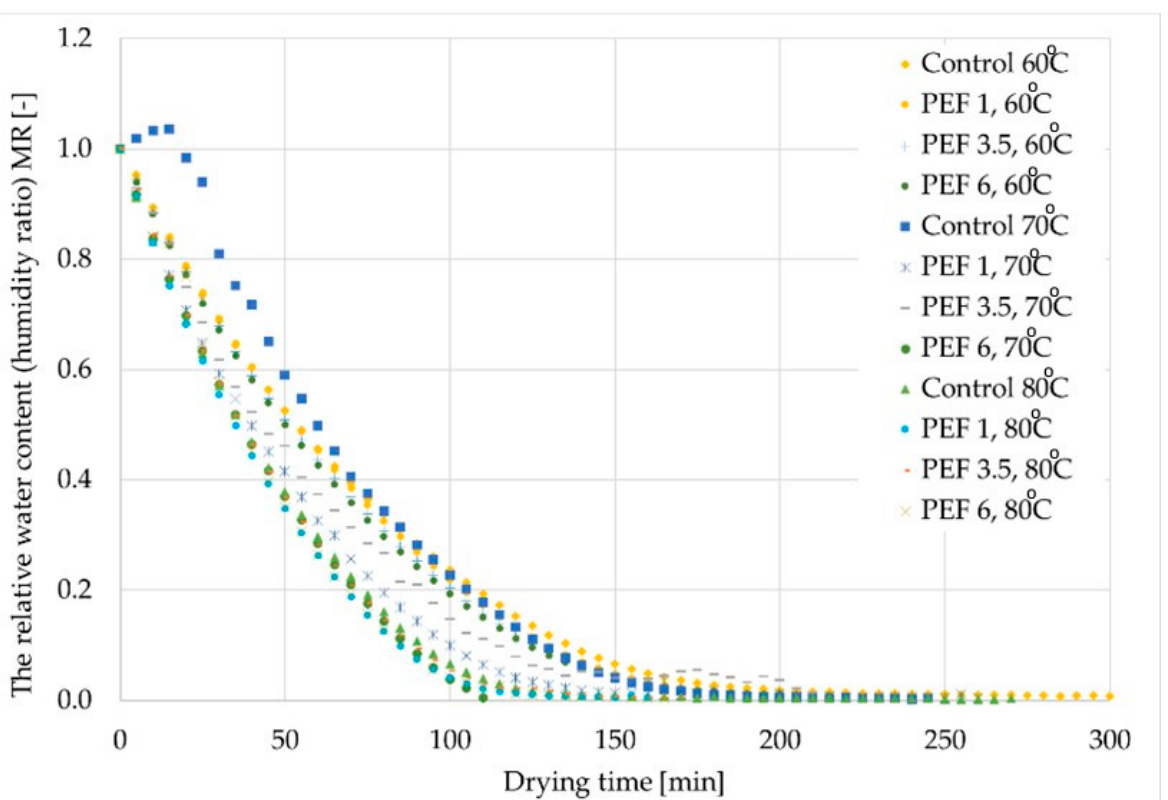
Figure 1. Kinetics of drying apple tissue at temperatures of 60, 70, and 80 ◦ C that has been pretreated with PEF at electric field intensity levels of 1, 3.5, and 6 kJ/kg.